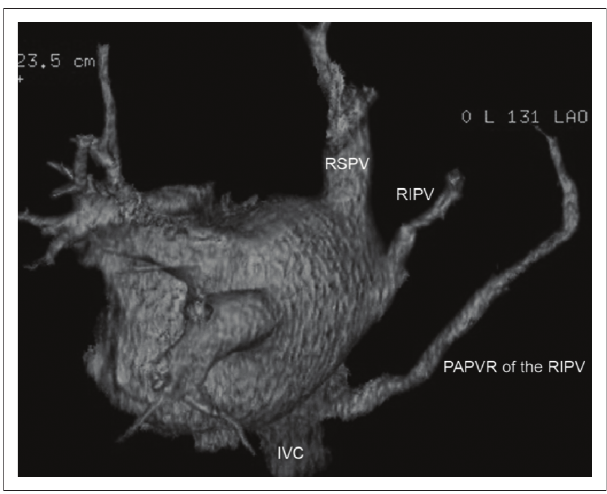
RIPV, Right inferior pulmonary vein; PAPVR, partial anomalous pulmonary venous return; IVC, inferior vena cava. FIGURE 15: Partial anomalous pulmonary venous return in a 62-year-old man. One right inferior pulmonary vein drains into the left atrium, and another right inferior pulmonary vein drains into the IVC. Right inferior pulmonary vein (RIPV), partial anomalous pulmonary venous return (PAPVR of the RIPV) and inferior vena cava (IVC). Three-dimensional